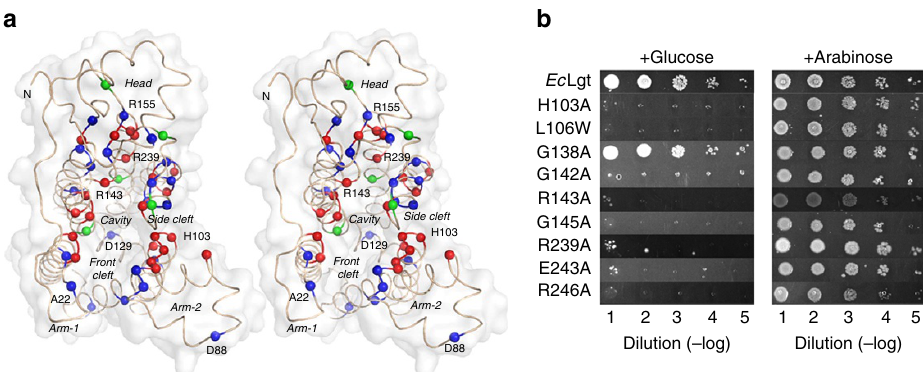
Figure 6 | Mutational screening of Lgt structure. ( a ) Stereo top view of the Lgt backbone structure. Positions in which all mutations result in severe or total loss of activity are represented by red spheres; those in which all mutations showed little or no effect are represented by blue spheres; and others in which only some mutations lost activity are represented by green spheres. ( b ) Selected results of the complementation assay for Lgt variants (see Supplementary Fig. 3c for the complete set). For each variant of Lgt, a serial dilution of cell culture was spotted onto solid medium containing either 11mM glucose (left columns) or 1mM arabinose (right columns). Photos were taken 16h after incubation at 37 (cid:2) C. Appearance of colonies indicated functional